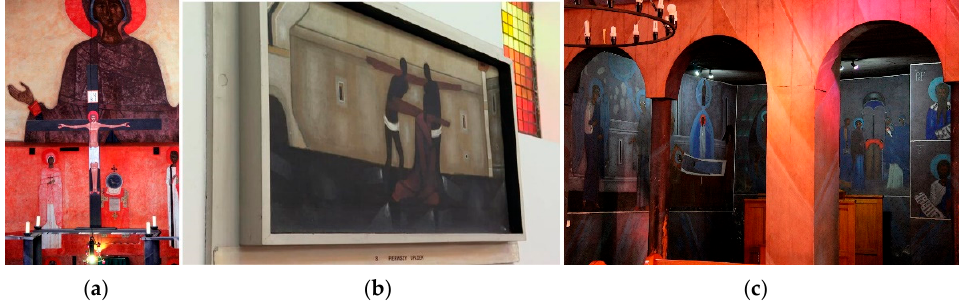
Figure 11. Roman Catholic Church in Wesoła: ( a ) detail of the presbytery; ( b ) Stations of the Cross; ( c ) view from the nave into the narthex. Photography by Iwona Bal. Reproduced with permission.